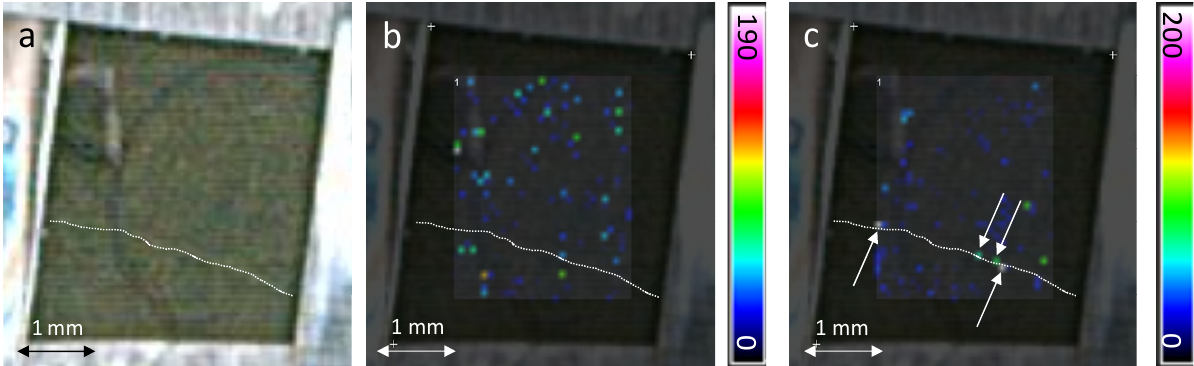
Figure 5. MALDI-MSI of grapevine leaf 5 days after infection by Plasmopara viticola ( a ) optical image; ( b ) ion extracted image of resveratrol/piceids at m/z 229; ( c ) ion extracted image of viniferins at m/z 454 and 455. The color scale indicates the absolute intensity of each pixel (arbitrary units). The dotted line highlights a small vein and the arrows point out pixels corresponding to a high intensity of